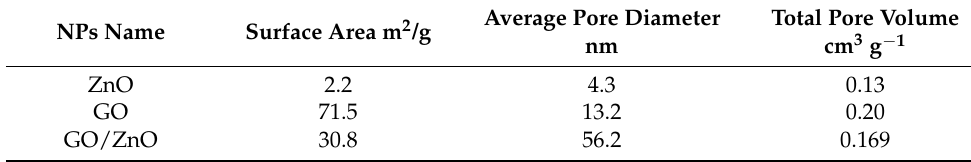
Figure 7. BET-specific surface area for synthesized GO, ZnO, and rGO-ZnO NPs. Table 1. Surface area parameters obtained from BET surface area